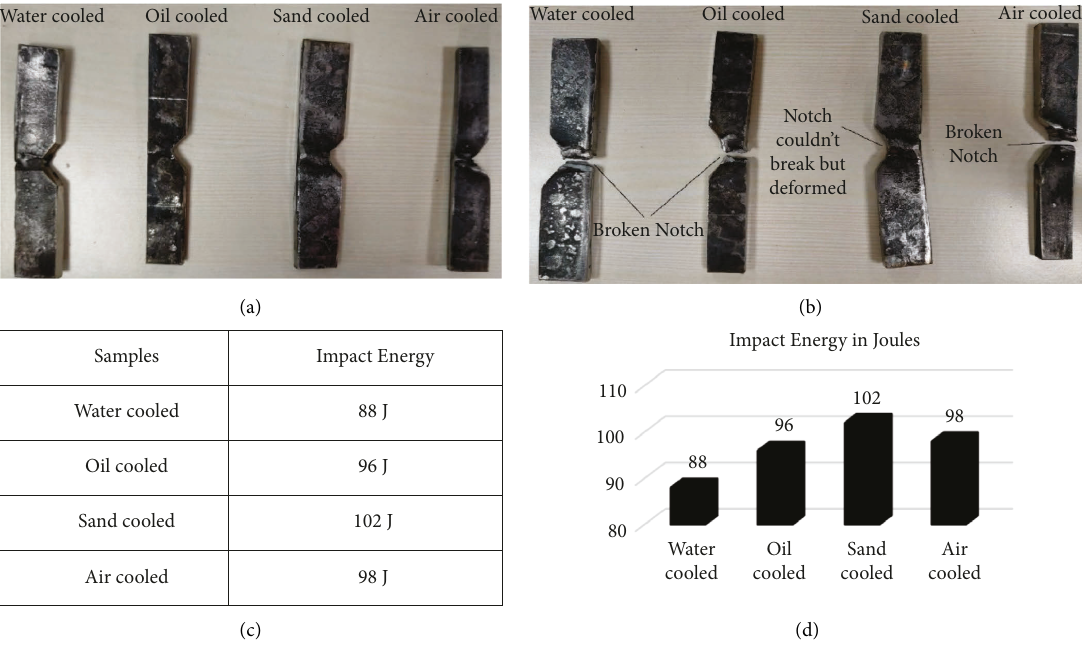
Figure 7: (a) Specimens of impact strength analysis. (b) Broken samples after test. (c) Values of impact strength. (d) A comparative analysis among all